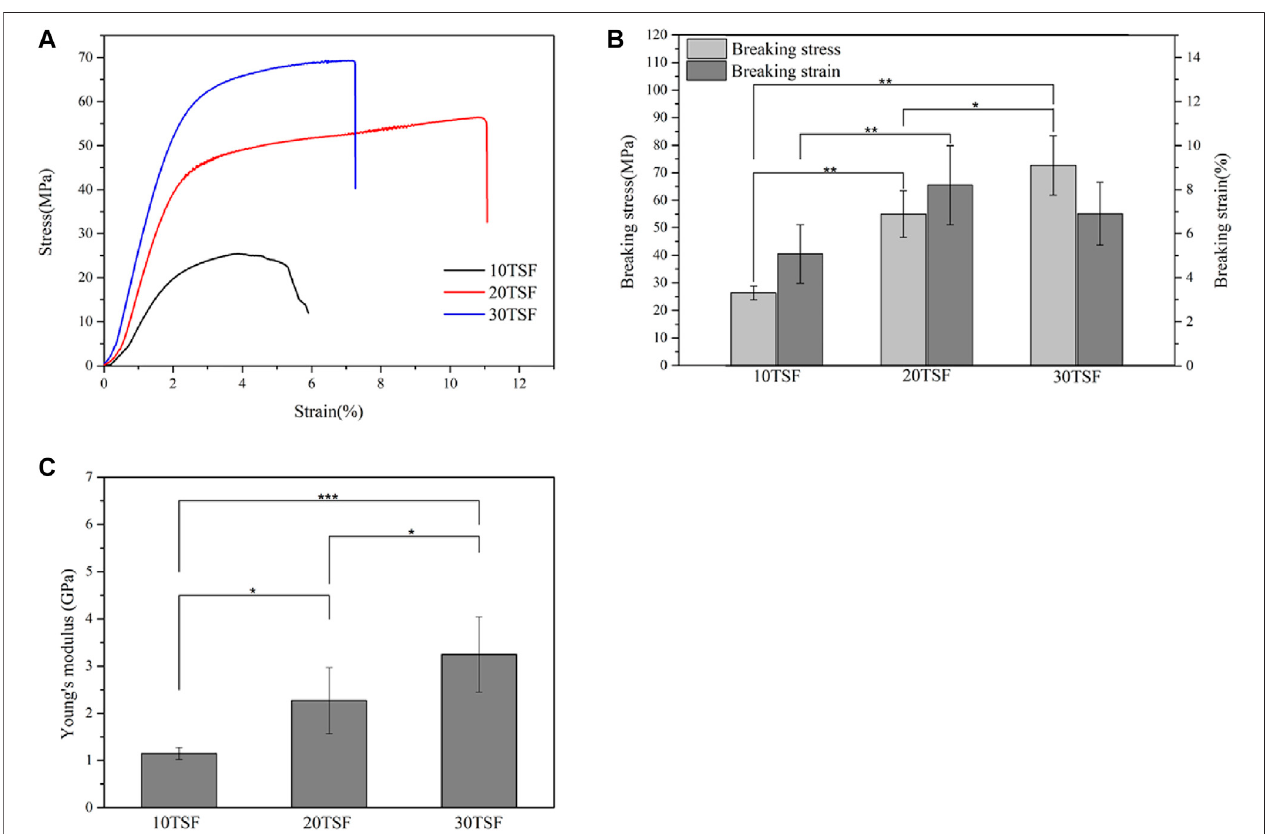
FIGURE 6 | Mechanical properties of TSF nano fi ber mats after 10-, 20-, and 30-min physical shearing (A) Stress – strain curves (B) Breaking stress and breaking strain (C) Young ’ s modulus of the nano fi ber mats (* p < 0.05, ** p < 0.01, *** p < 0.001).